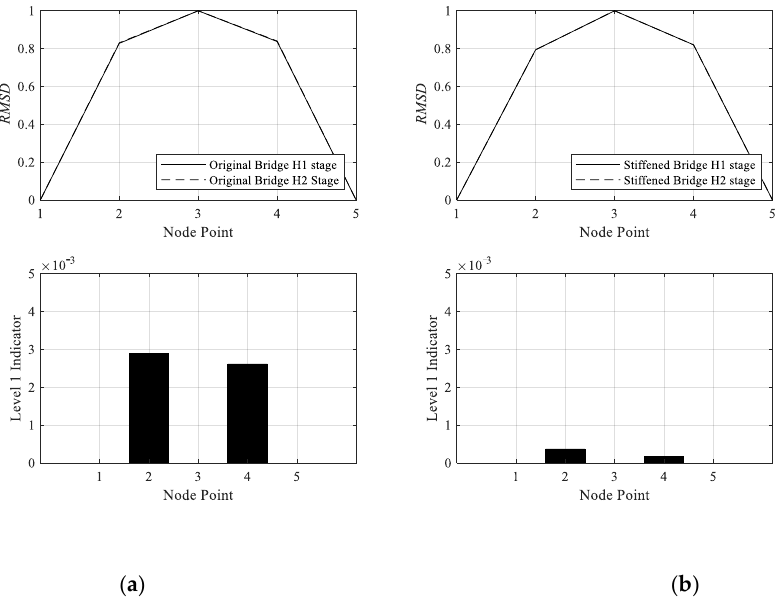
Figure 16. Level 1 damage indicator of ( a ) original bridge with H1 and H2 directions; ( b ) stiffened bridge with H1 and H2 directions.